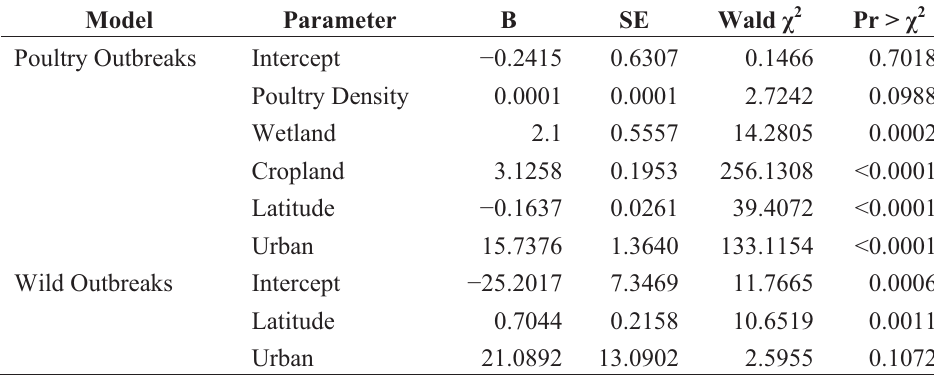
Table 5. Best-fit models and significant parameters for poultry and wild bird outbreaks in the Central Asian Flyway. Best-fit models with parameter values for poultry and wild bird HPAI H5N1 disease outbreaks within the Central Asian Flyway and migratory pathway of ruddy shelducks marked at Qinghai Lake, China, 2007 – 2008. Models were selected by forward and backward stepwise selection using AIC c values for entry and removal from models. Variables include percent wetland (Wetl), cropland (Crop), developed land (Dev), and grassland (Grass), as well as latitude (Lat), poultry density (Pdens), and a seasonal ruddy shelduck utilization distribution (RUSHUD) for satellite marked